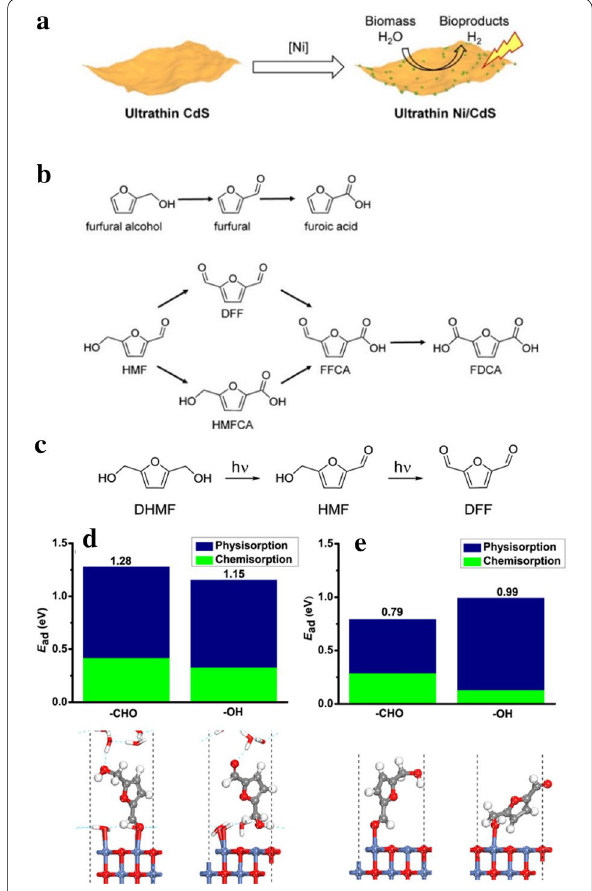
Fig. 7 a The illustration of the synthetic route of Ni/CdS nanosheets. b Oxidation reactions of the alcohol and aldehyde groups in HMF. c Oxidation of DHMF to HMF and DFF. Adsorption structures and energies of MHF d at water/NiO interface and e over bare NiO surface vias its aldehyde or alcohol group. Reprinted with the permission from Han et al. [6] (Copyright 2017 American Chemical Society)